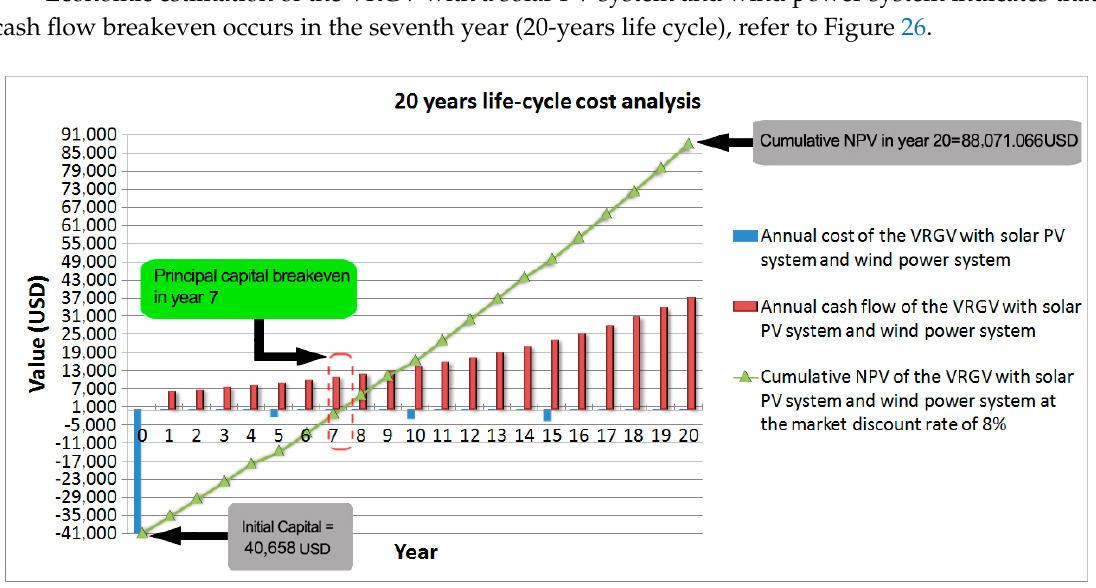
Figure 26. 20 years cost-effectiveness analysis of the VRGV with solar PV system and wind power system.